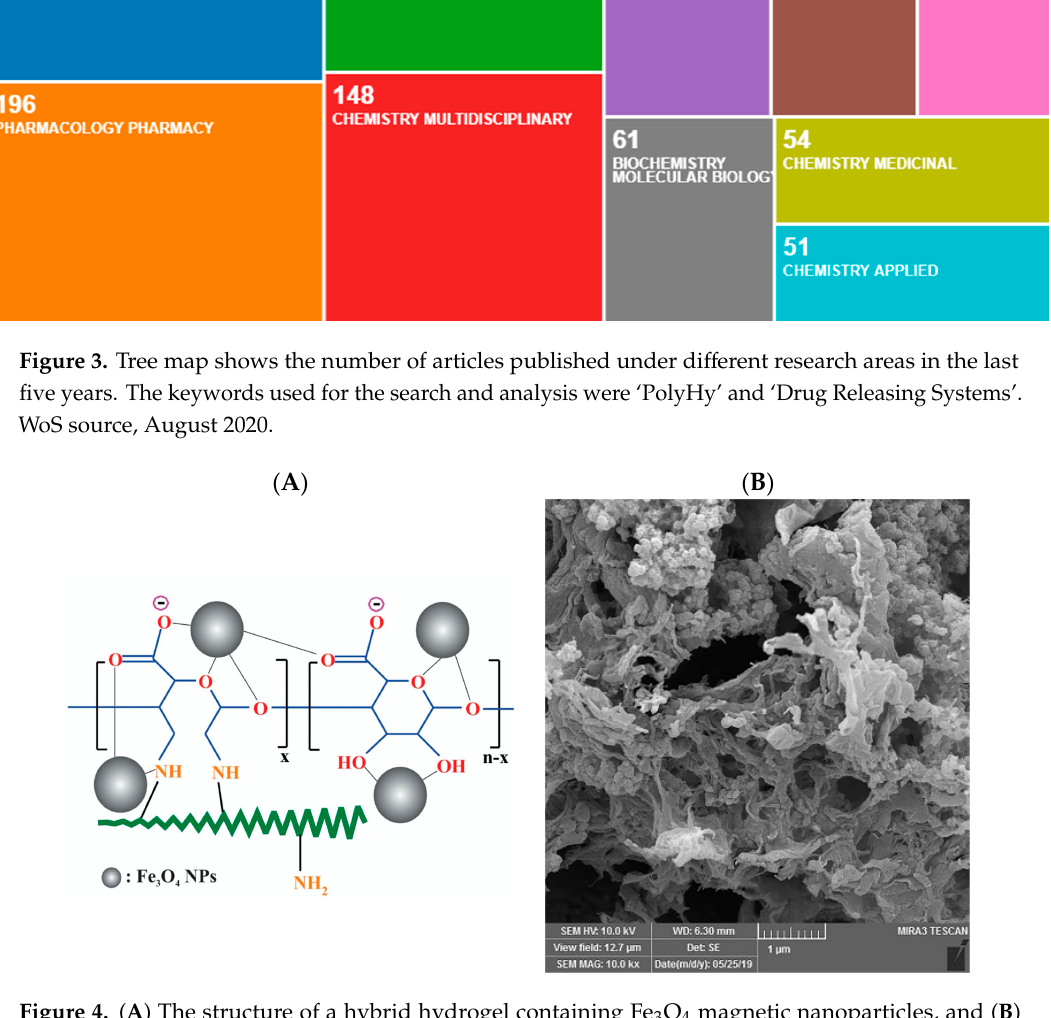
Figure 4. ( A ) The structure of a hybrid hydrogel containing Fe 3 O 4 magnetic nanoparticles, and ( B ) microporous structure determined by SEM. The images were extracted and adapted from reference [87].